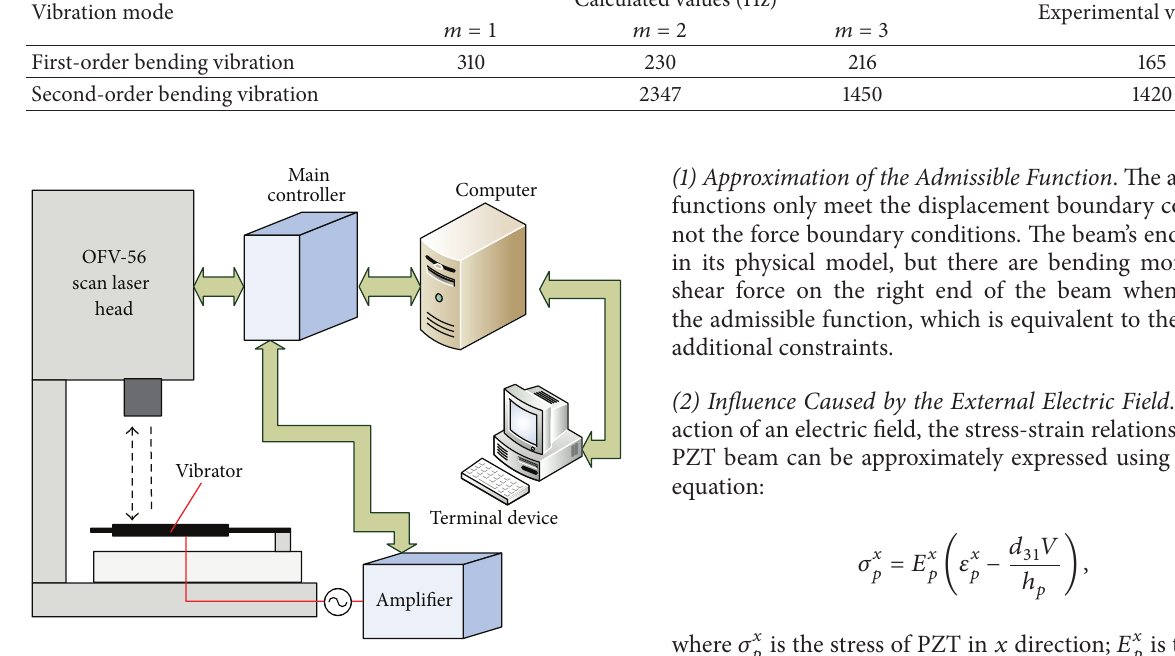
Figure 2: Laser Doppler vibration measuring for